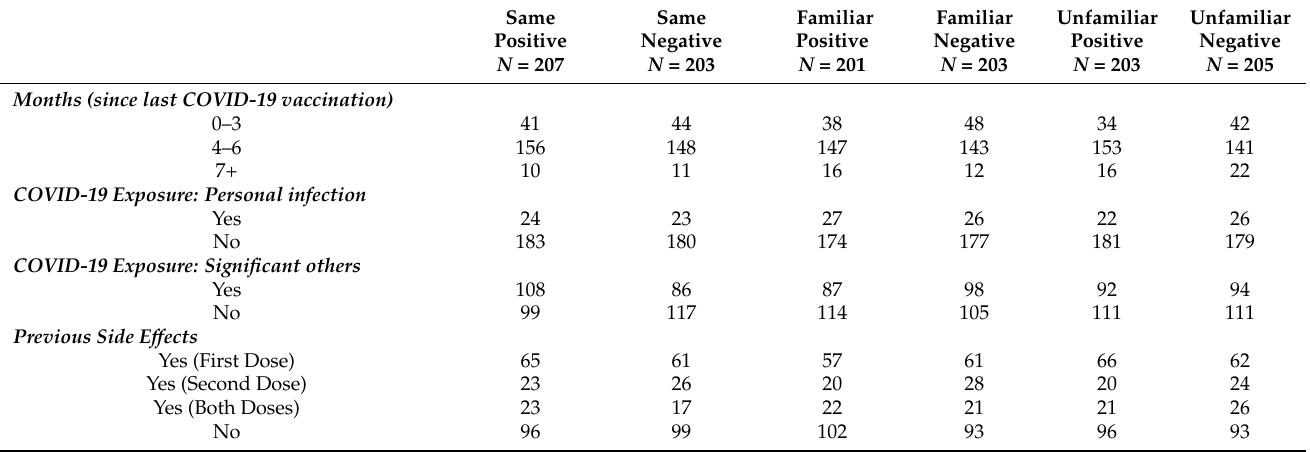
Table 2. Descriptive statistics (frequency counts) regarding vaccine and COVID-19 history for each experimental